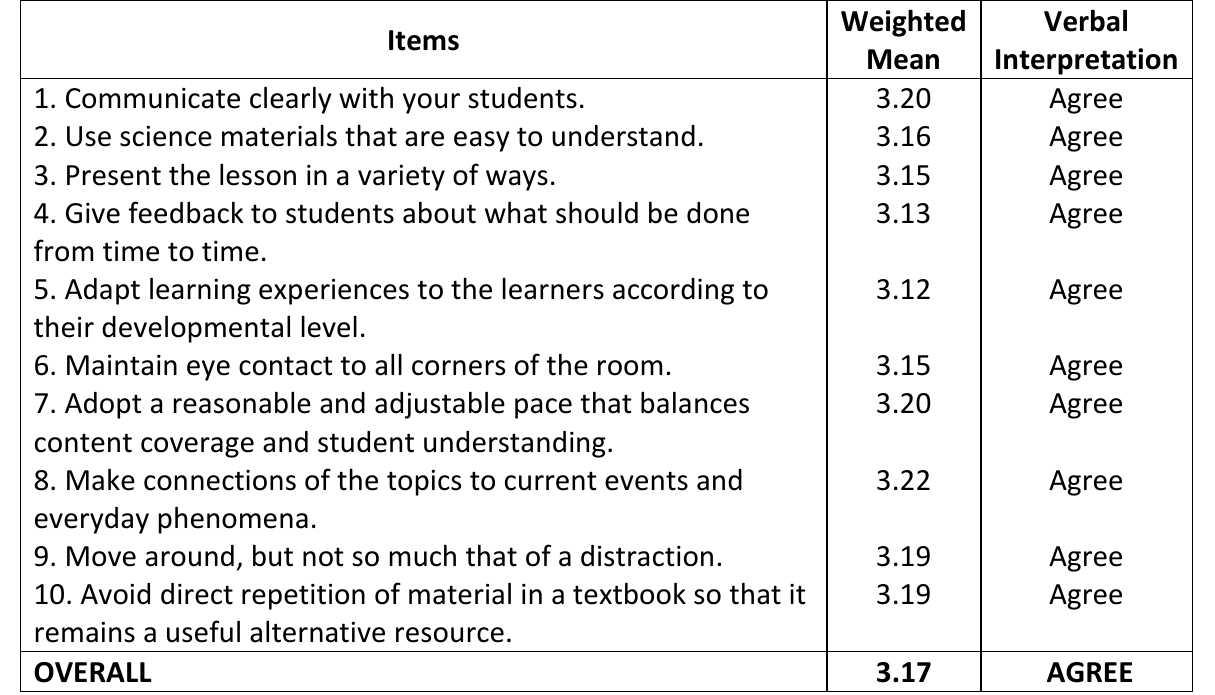
Table 9 : Weighted Means of the Factors Affecting Students’ Progress as to Teaching